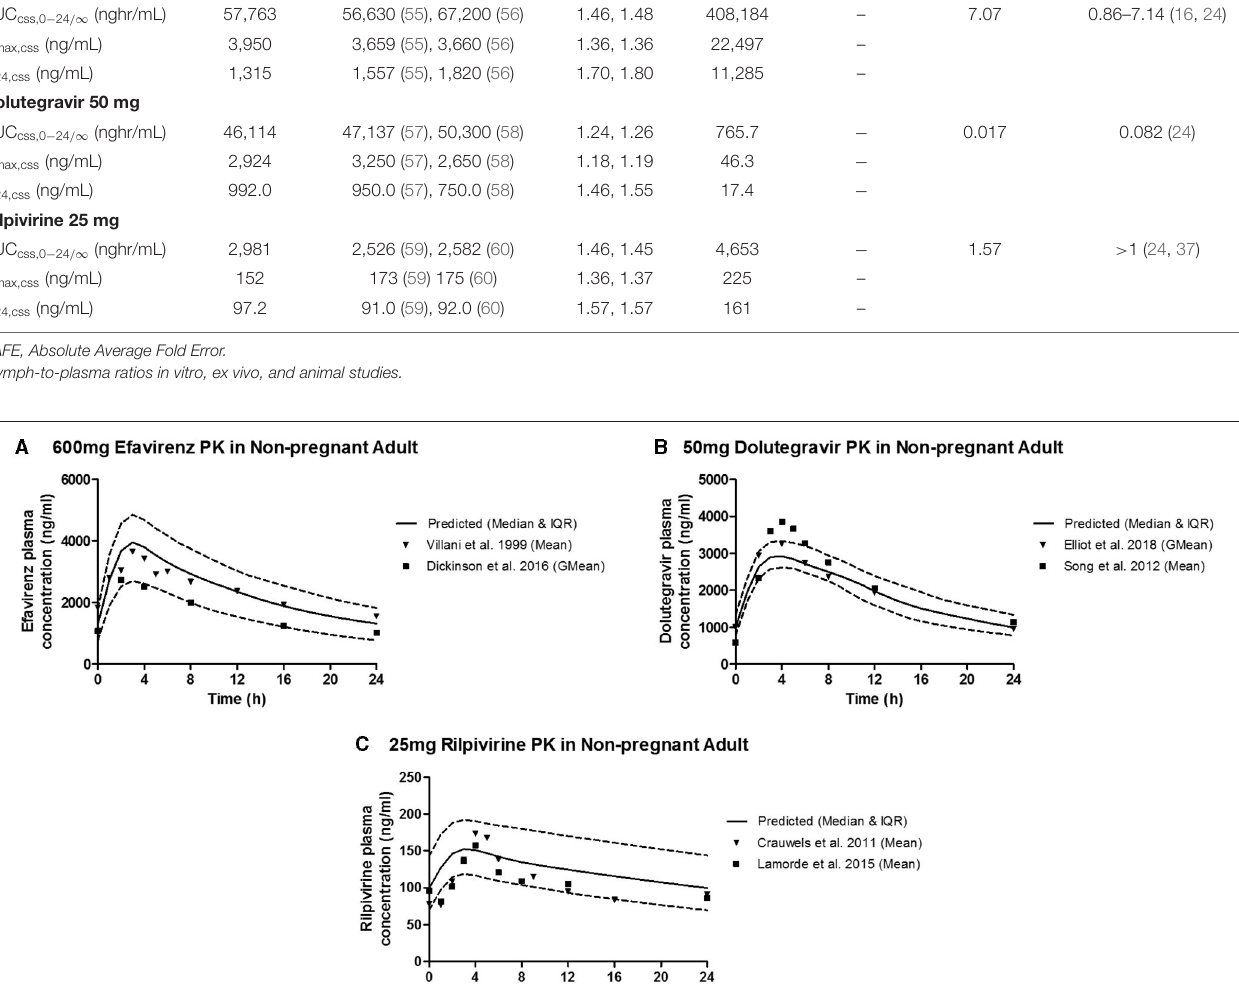
profiles were comparable with clinically observed maternal plasma concentration-time profiles in third trimester ( Figure 3